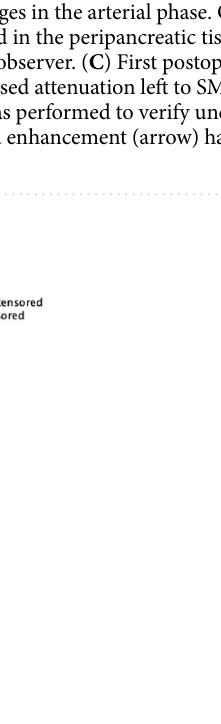
Figure 7. Kaplan-Meier survival analysis in patients with PDAC with and without